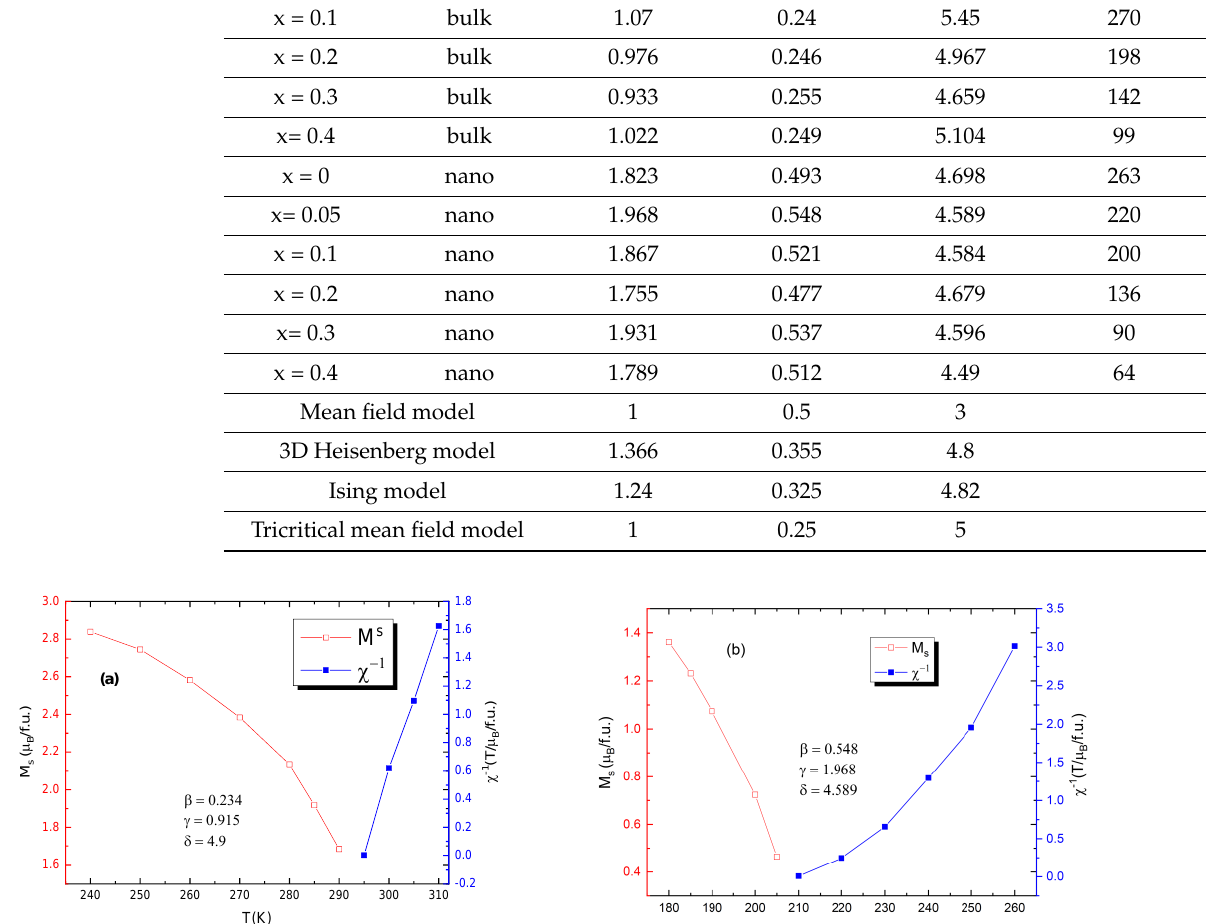
Figure 9. Calculated values for critical exponents for ( a ) the bulk sample with x = 0.05 ( b ) for the nanocrystalline sample with x =